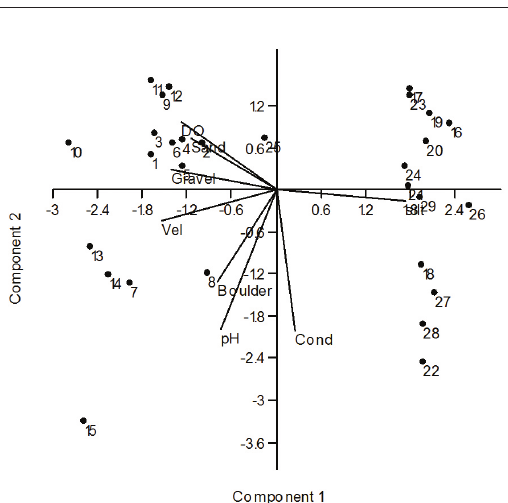
Figure 2. Ordination of 29 streams in São Paulo State generated by applying Principal Component Analysis to environmental variables (pH, electrical conductivity, DO, stream velocity of water and percent boulder, gravel, sand and silt in the streambed). Components 1 and 2 explain 43.79% and 26.55% of the variability